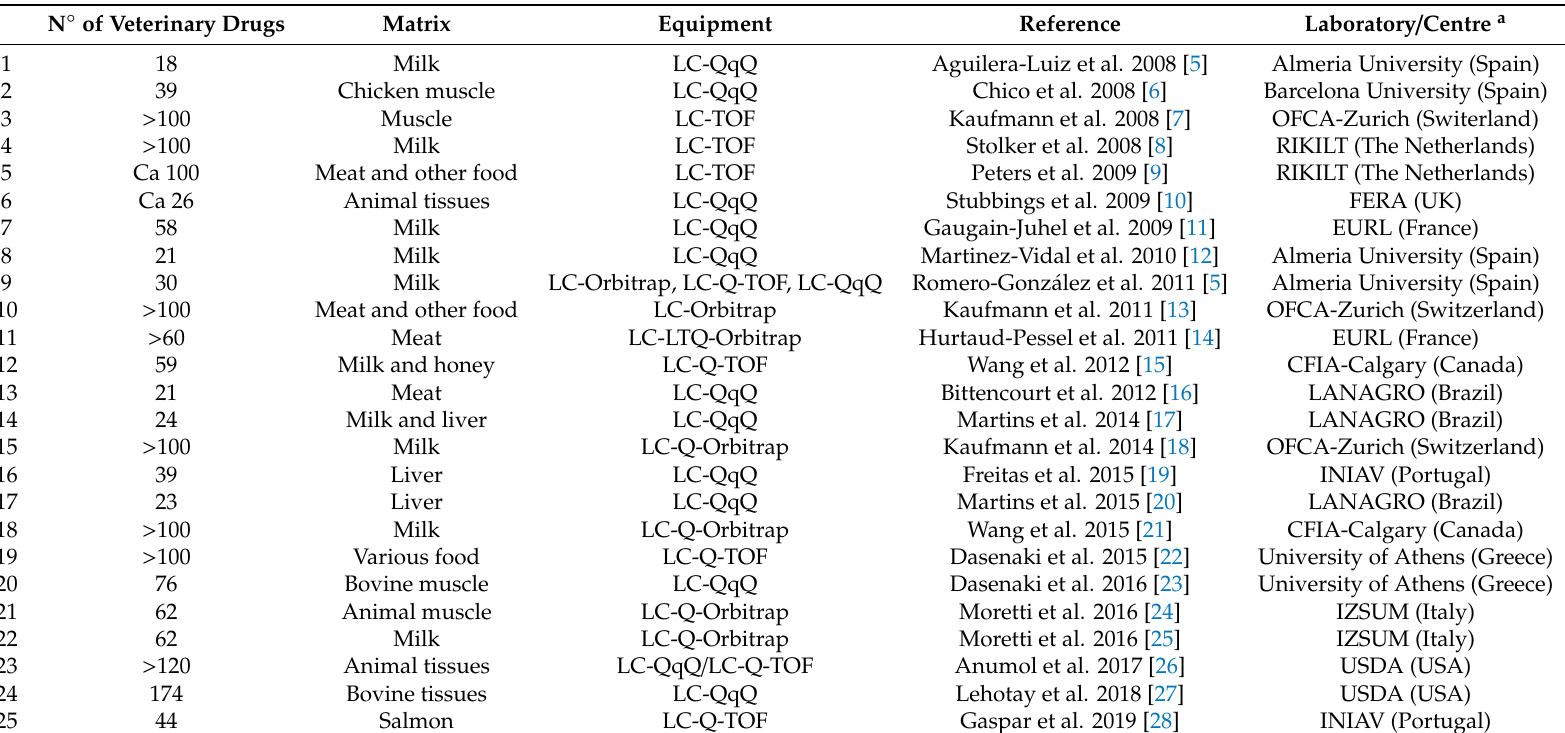
Table 1. Overview of multiclass methods for the determination of veterinary drug residues in tissues and